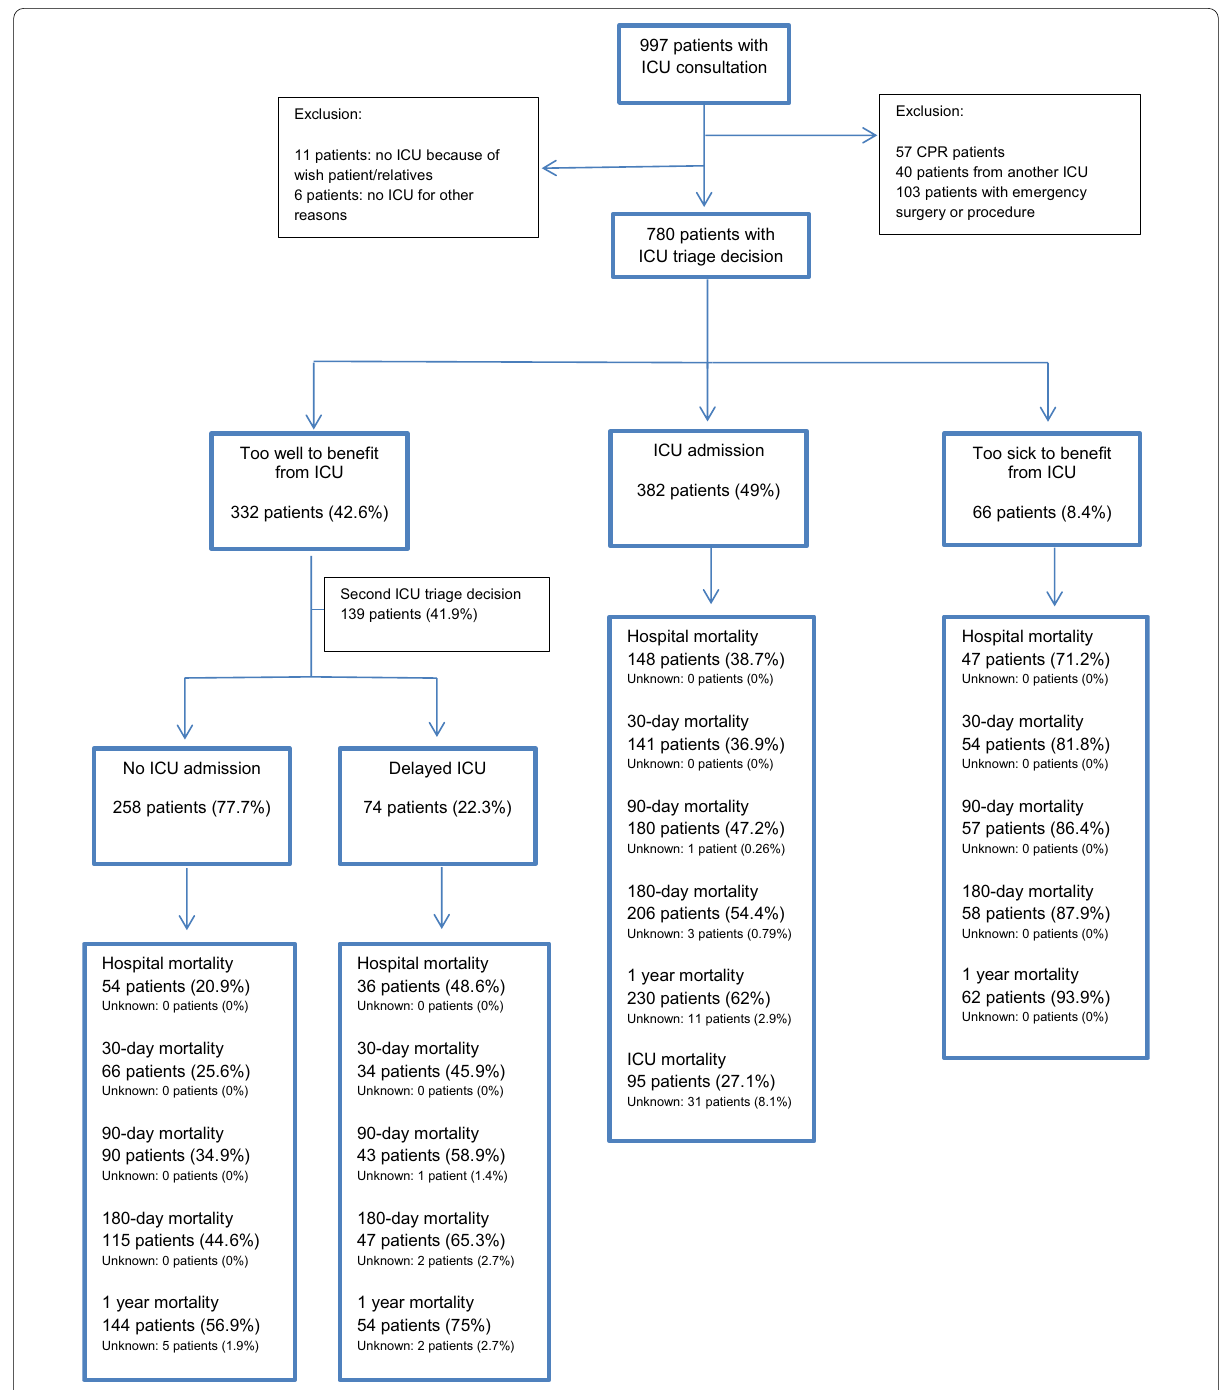
Fig. 1 Flowchart study: number patients, ICU triage decisions and